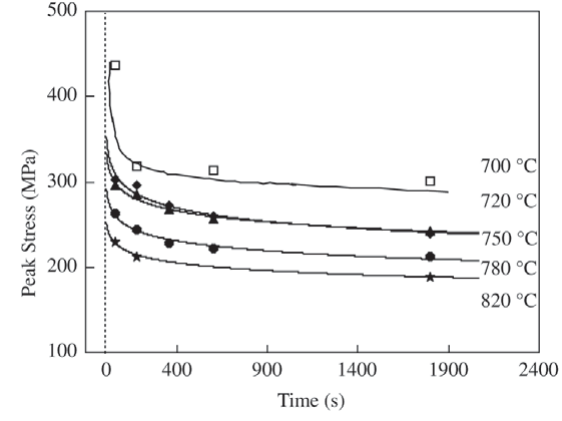
Figure 2. Evolution of the volume fraction of ferrite as a function of temperature in experiments conducted without any deforma- tion.